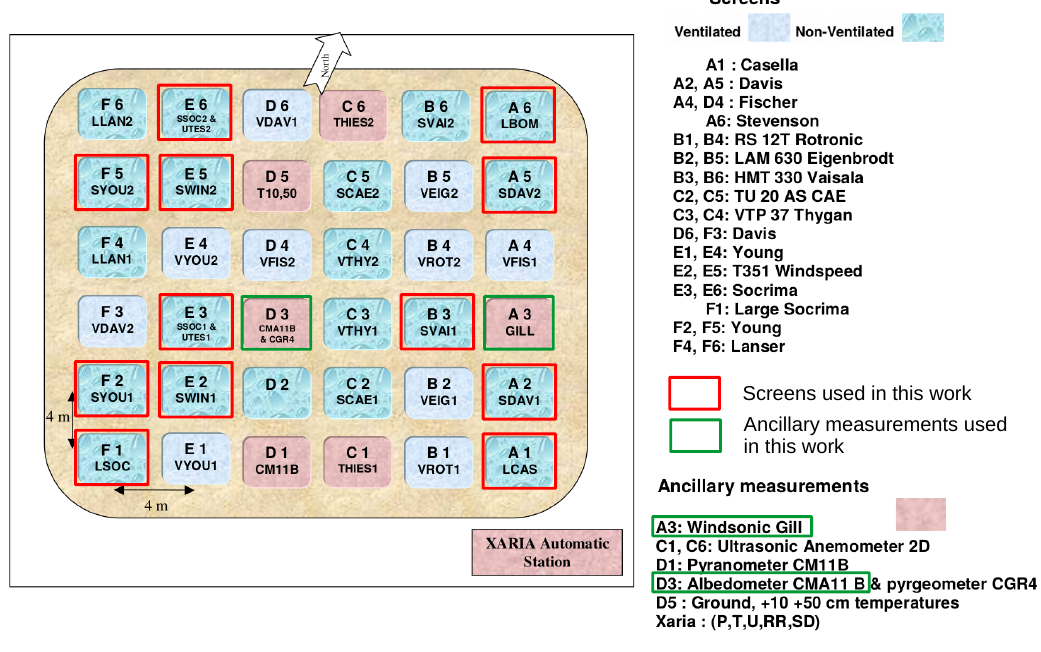
Screens used in this work